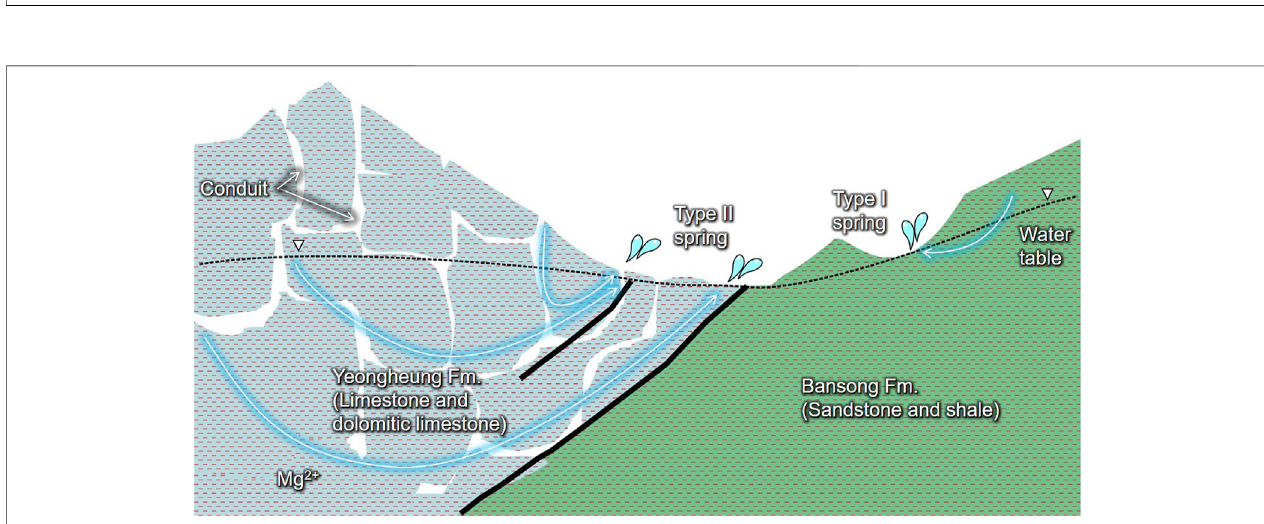
FIGURE 8 | Summary of subsurface fl ow in the studied karst area with Cambro-Ordovician dolomitic limestone overlying Jurassic metamorphosed shale and sandstone along thrusts. The conduit- fl ow-dominated Type Ⅱ springs discharge deep groundwater and contaminants in fi ltrating the subsurface, whereas the diffuse- fl ow-dominated Type Ⅰ springs discharge rainwater carrying contaminants and dissolving calcite via shallow circulating pathways and little water-rock interactions in mountain areas.